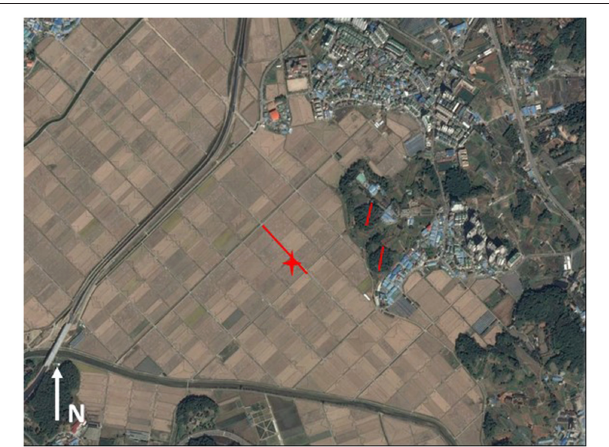
FIGURE 2 | Example of the brumation and winter field observations at site #1, Sihung, located 37.406 ◦ N and 126.805 ◦ E. The red lines represent the transects, in the rice paddies in the west and in the forests in the east. The red star indicates the site where the hibernating female was found during the winter field observations. This map was generated with Google Earth Pro (v7.1.2.2041, 2013) on maps from 2016 SKEnergy, Image Landsat